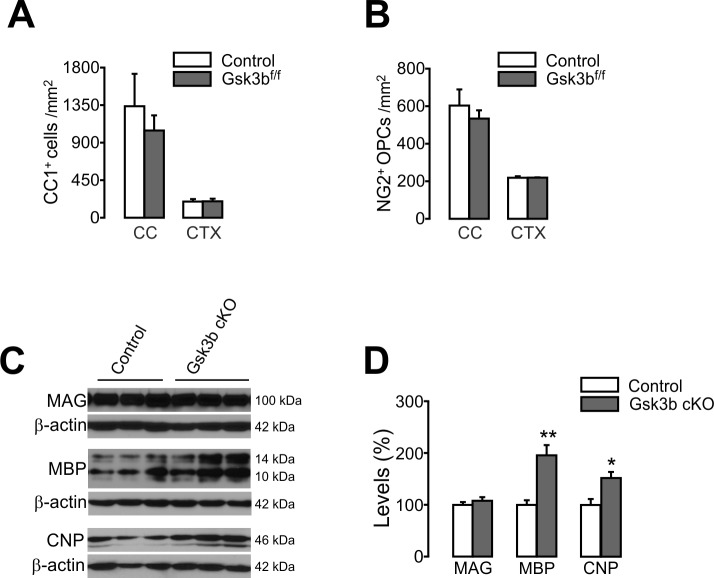
OL-specific Gsk3b ablation does not change the number of oligodendrocyte, but enhances expression levels of MBP and CNP.(A) Quantification of CC1+ OLs in the CTX of the control (Mog-iCre; R26-EYFP) and OL-specific Gsk3b cKO (Mog-iCre; R26-EYFP; Gsk3bf/f) mice at P31. (B) Quantification of NG2+ OPCs. n = 3 mice per group for (A, B). (C, D) Western blot analysis of cortical lysates for myelin proteins, MAG, MBP, and CNP. Cortices were isolated from Gsk3bf/f (control) and Mog-iCre; Gsk3bf/f (Gsk3b cKO) mice (P31). n = 4 mice per group for (C, D). Data are represented as mean ±S.E.M. *p<0.05, **p<0.01. Unpaired Student's t-test. The numerical data for the graphs are available in Figure 9—figure supplement 1—source data 1. Original western images are available in Figure 9—figure supplement 1—source data 2. List of source data files.10.7554/eLife.32021.035Figure 9—figure supplement 1—source data 1.Numerical data for graphs in Figure 9—figure supplement 1.10.7554/eLife.32021.036Figure 9—figure supplement 1—source data 2.Original western blot images used for Figure 9—figure supplement 1C,D.Full-length western blot images from three separate blots (A, B, and C). The blots were re-probed with β-actin Ab as indicated. The original images were cut as indicated with dashed-line boxes. The asterisk indicates non-specific signals.